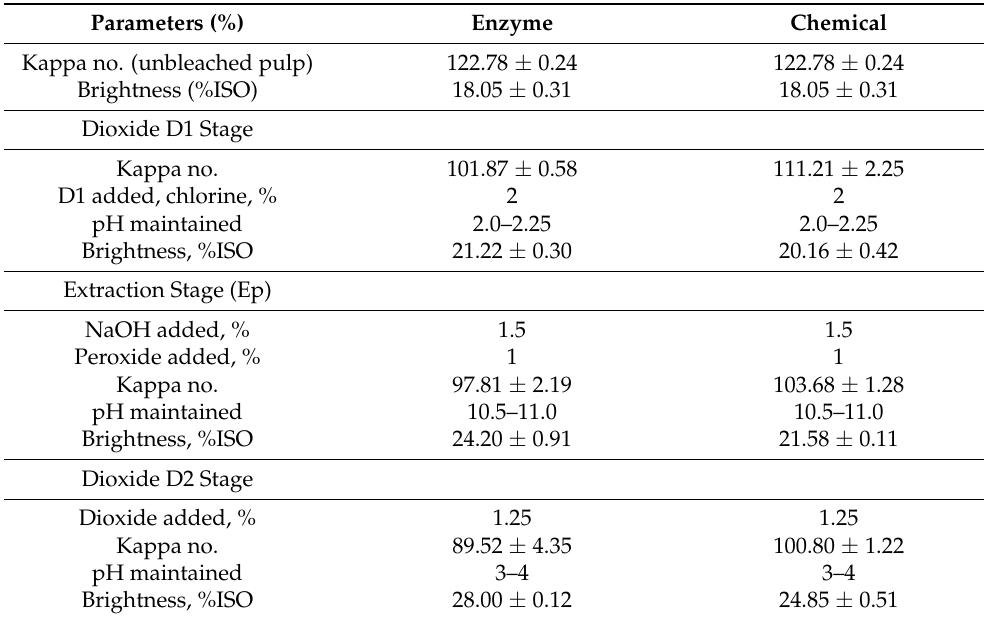
Table 5. A comparison of oil palm empty fruit bunch (OPEFB) pulp attributes according to chemical bleaching and enzymatic bleaching